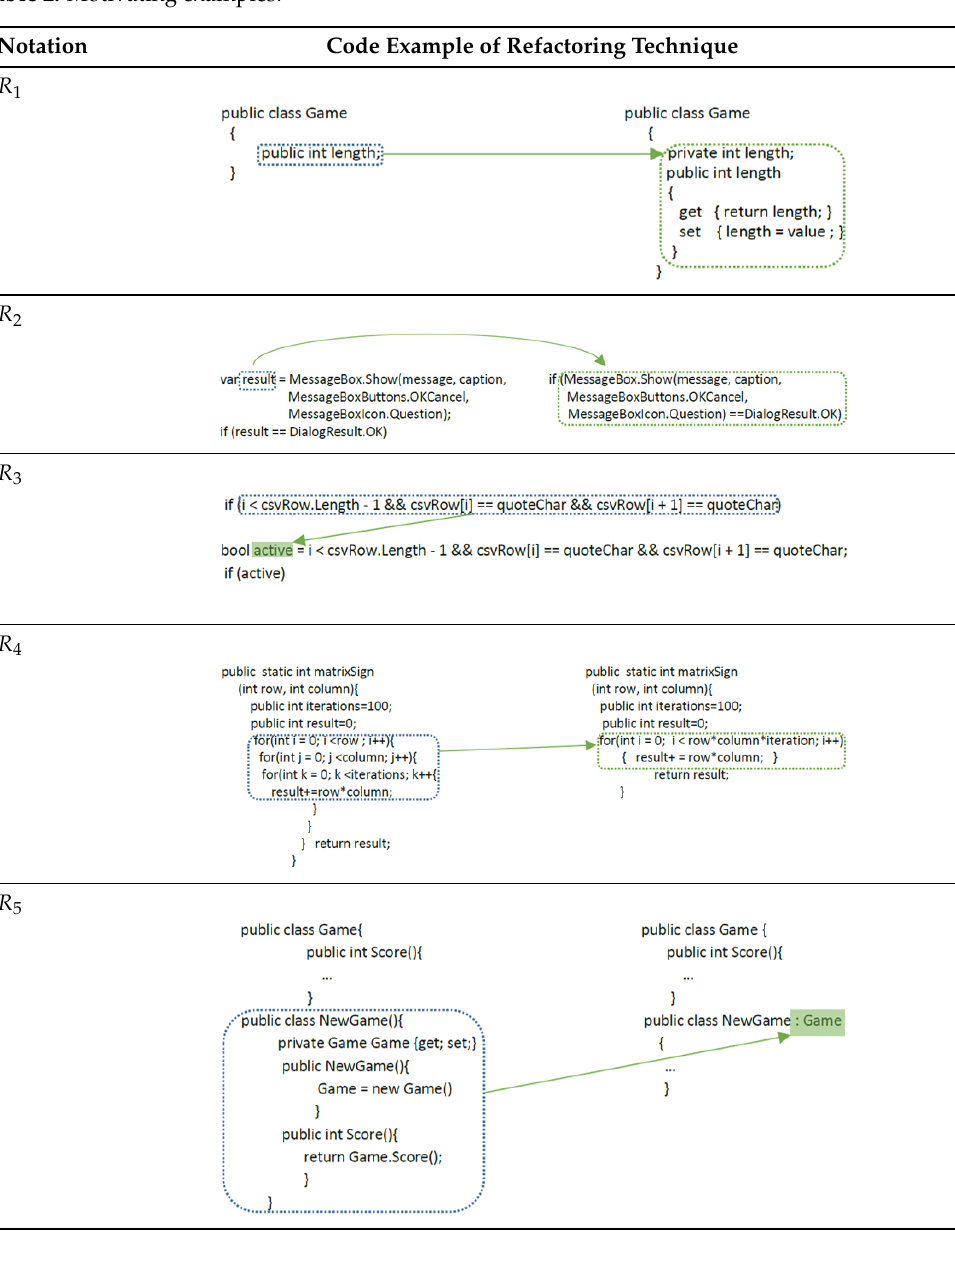
Table 2. Motivating